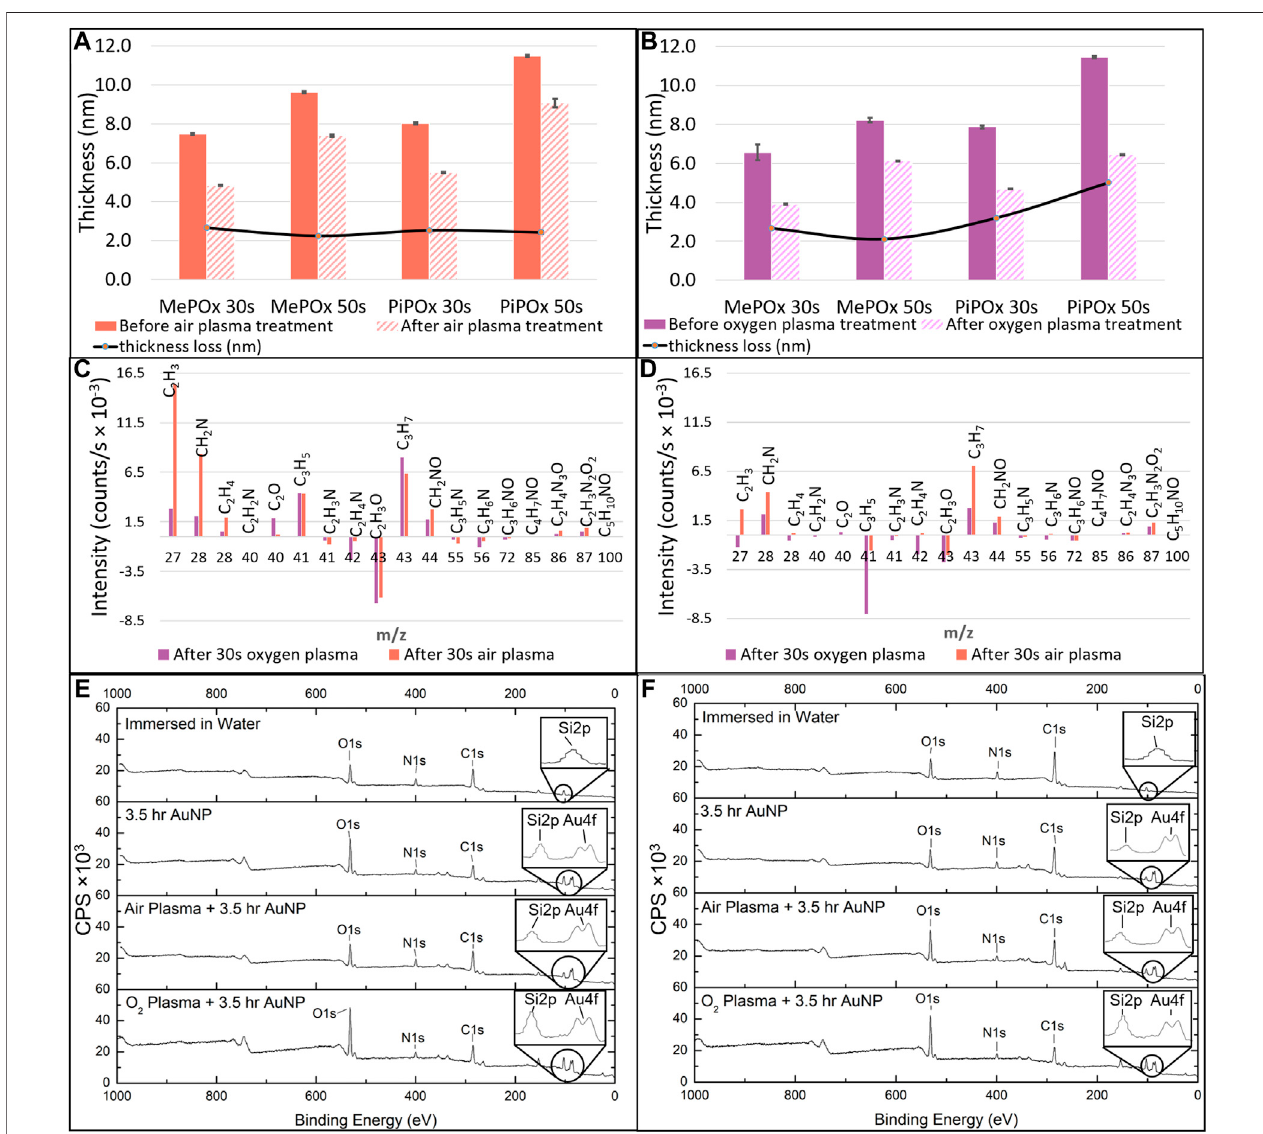
FIGURE 3 | MePOx and PiPOx film thickness as determined by ellipsometry before and after 30 s air plasma treatment (A) and oxygen plasma treatment (B) . Relative changes in molecular fragments detected by ToF-SIMS before and after oxygen or air plasma treatment on MePOx fi lms (C) and PiPOx fi lms (D) . XPS survey spectra for MePOx (E) and PiPOx (F) 50 s fi lms after 3.5 h immersion in water, and after 3.5 h incubation with AuNPs with and without prior air and oxygen plasma activation. CPS refers to counts per